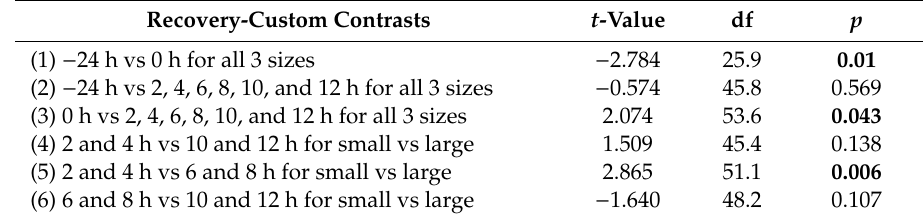
Table 2. Custom and interaction contrasts for the recovery experiment (see text for explicit descriptions of time intervals) (bold p <